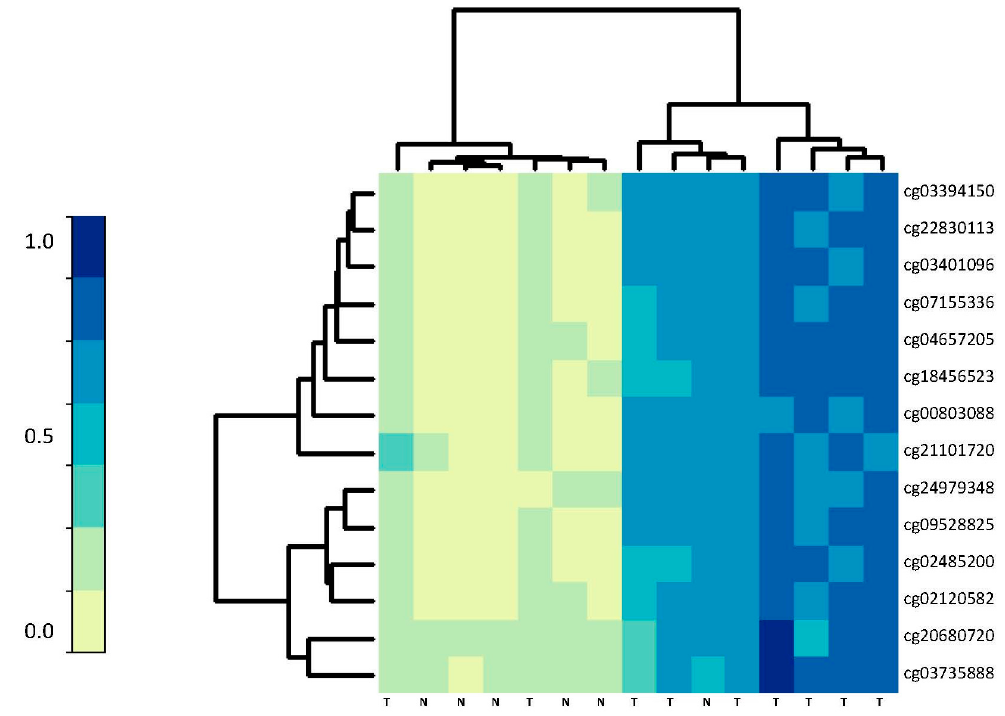
Figure 3. Methylation of dysregulated CpGs in MSI tumors vs. normal mucosa. An independent validation cohort of ( n = 9) MSI tumors vs. ( n = 6) normal mucosal samples are shown in columns. Rows represent the 15 dysregulated CpGs selected in the training datasets. The methylation levels are reflected by β -values from lowest (light yellow) to highest (dark blue). T indicates tumor, N indicates normal mucosa.